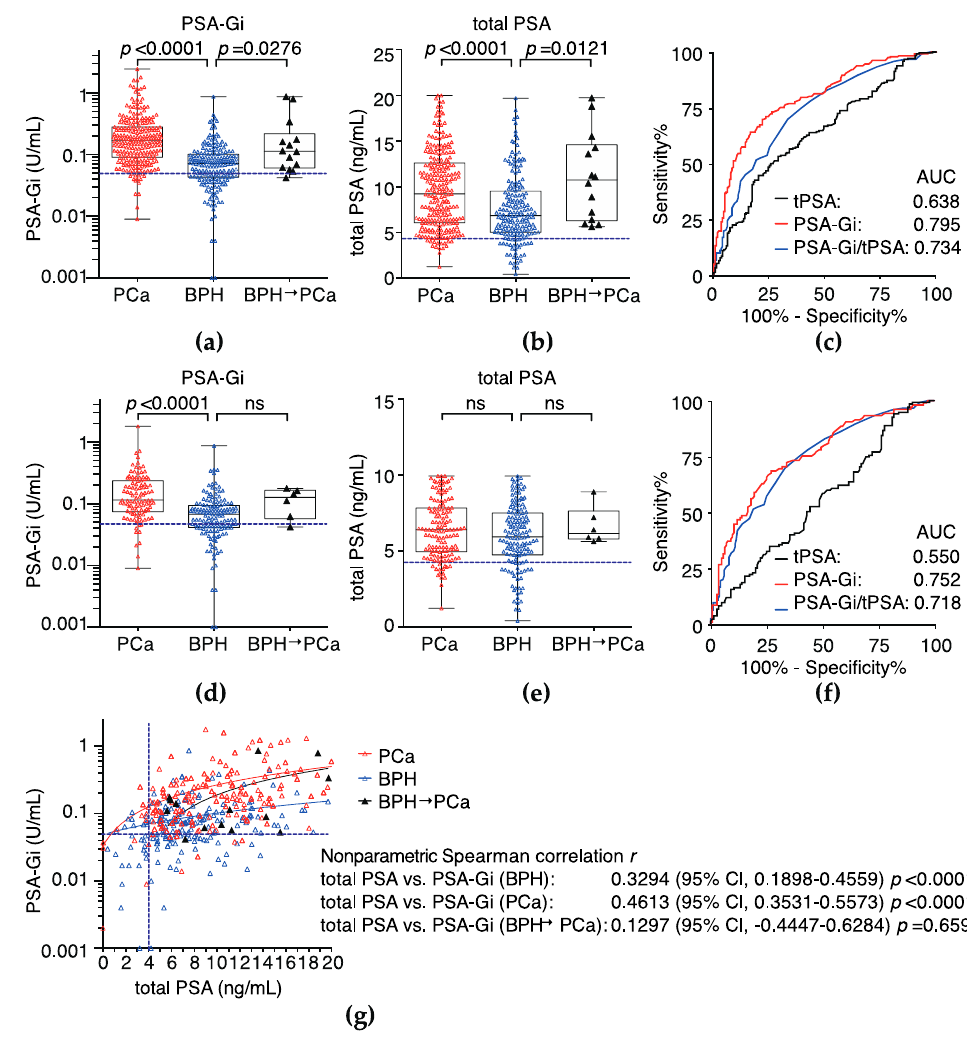
Figure 3. Serum levels of the PSA-Gi at Pbx in the patients who diagnosed as BPH or PCa by an